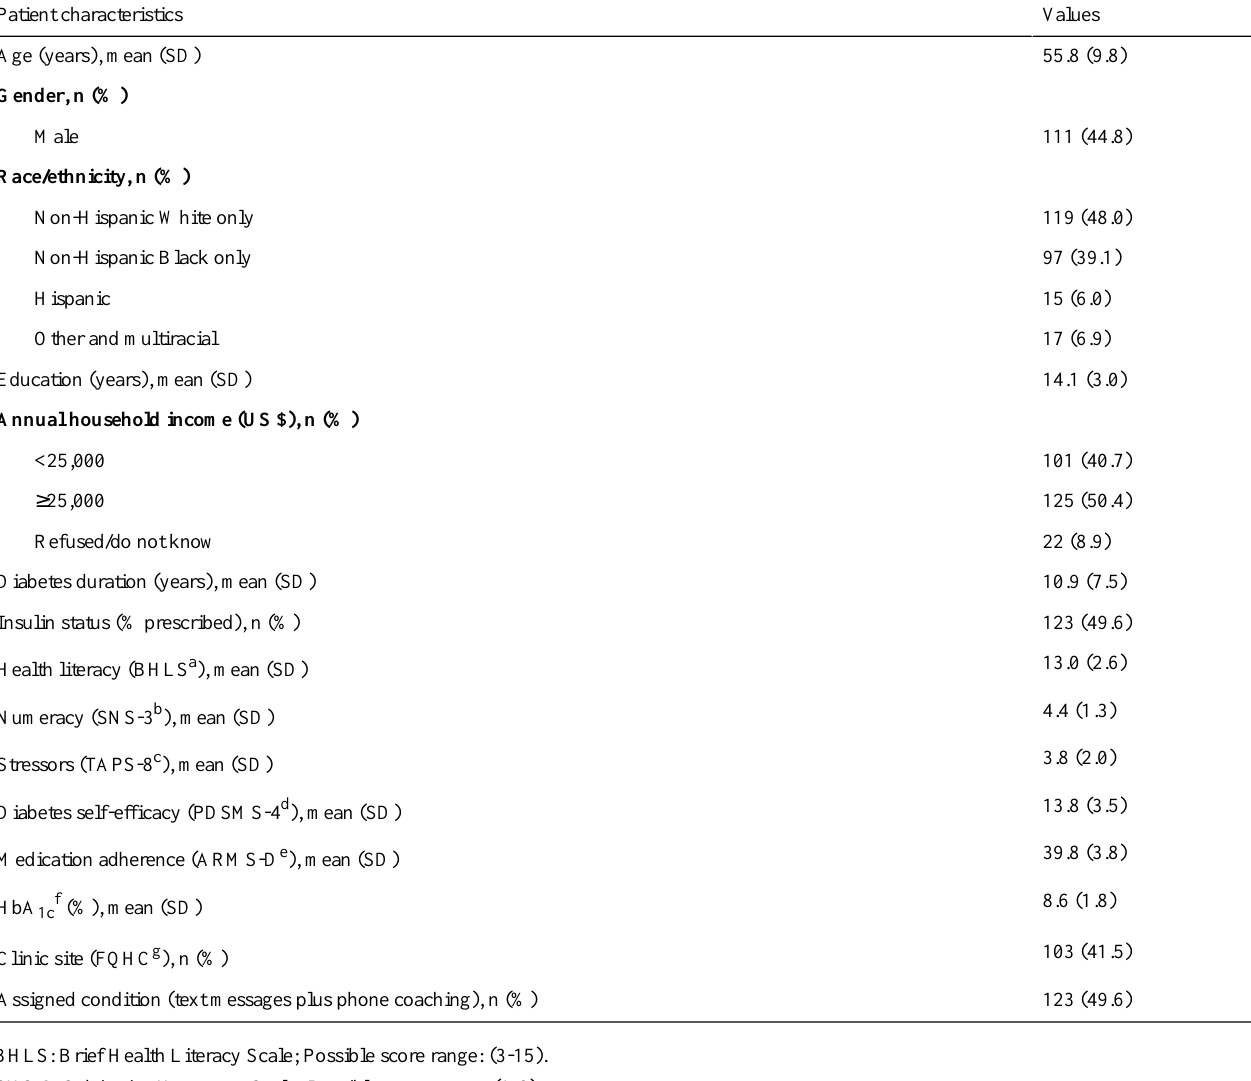
Table 1. Patient characteristics (N=248). ValuesPatient